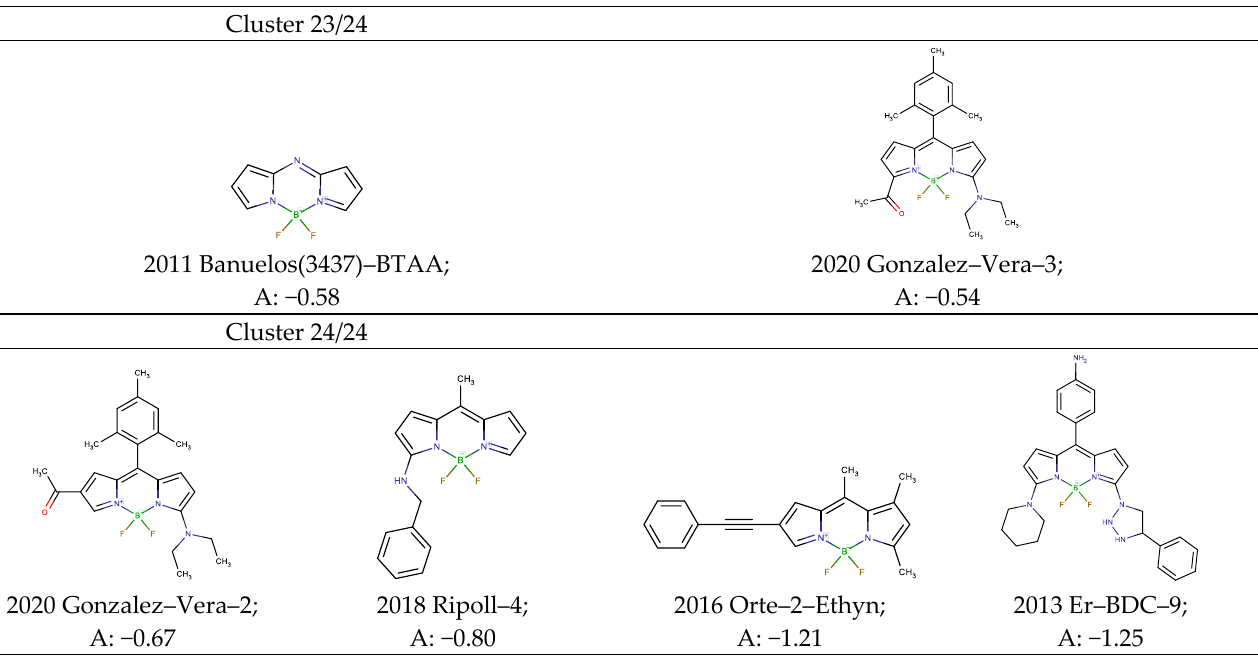
Scheme 8. Chemical structures of dyes in clusters 23/24 and 24/24, bearing a high negative solvato-